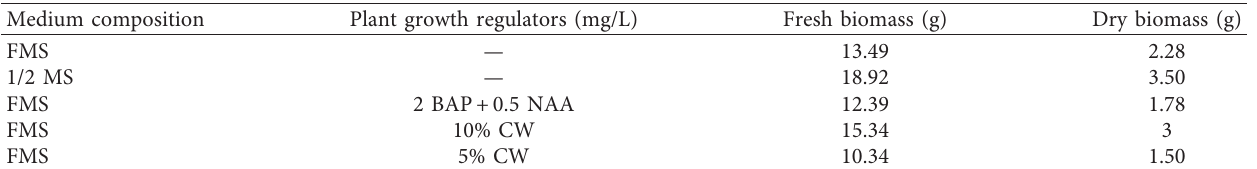
Table 1: Growth response of Dendrobium chryseum protocorms from seed culture to MS medium strengths in the presence or absence of phytohormones BAP, NAA, and CW.